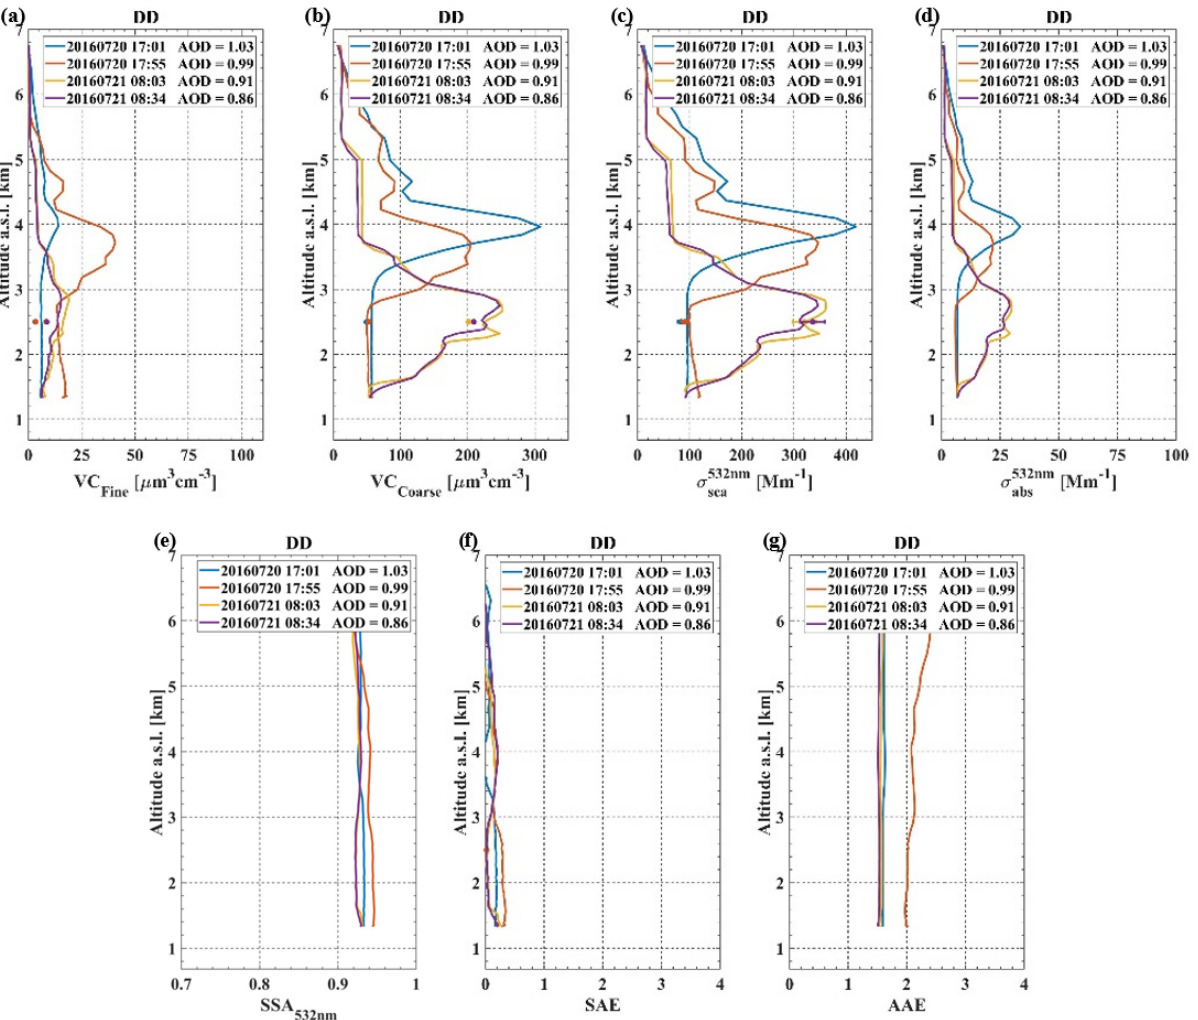
Figure 9. Volume concentration for (a) fine and (b) coarse modes, (c) scattering ( σ sca ) and (d) absorption ( σ abs ) coefficients, (e) single scattering albedo (SSA) at 532nm, (f) scattering Ångström exponent (SAE), and (g) absorption Ångström exponent (AAE) retrieved by GRASP (line) and the SNS measurements (point) during the desert dust event on 20 and 21 July 2016. The AOD shown is at